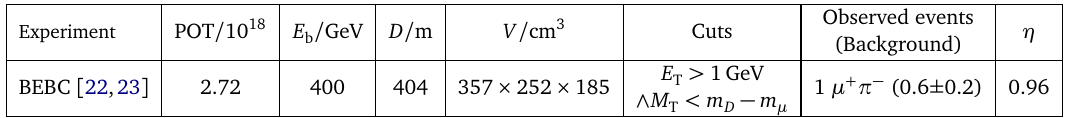
Table 1: The relevant experimental parameters for the CERN-WA66 experiment. POT is the total number of protons on target, E is the energy of proton beam, D is the b distance from the end of the target to the beginning of the detector and V is the detector volume written as transverse area × length; the dimensions of BEBC are given approximating the detector as a cuboid. Cuts are placed on the total energy of the charged pair E and on the transverse mass, as defined in Eq.(13). The number T of observed events is given, as well as the estimated background. The detection efficiency after cuts is denoted as η